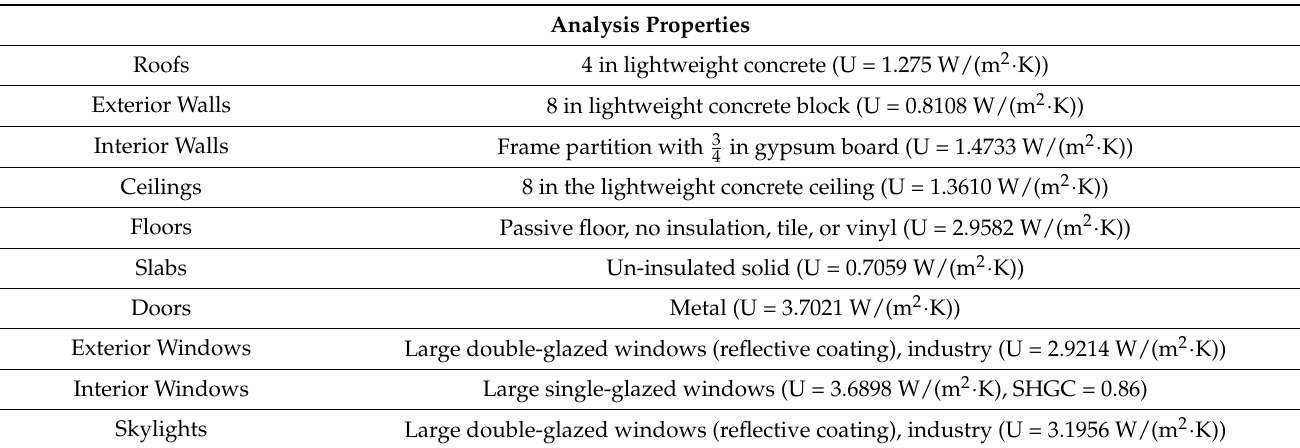
Table 5. Summary of energy simulation override